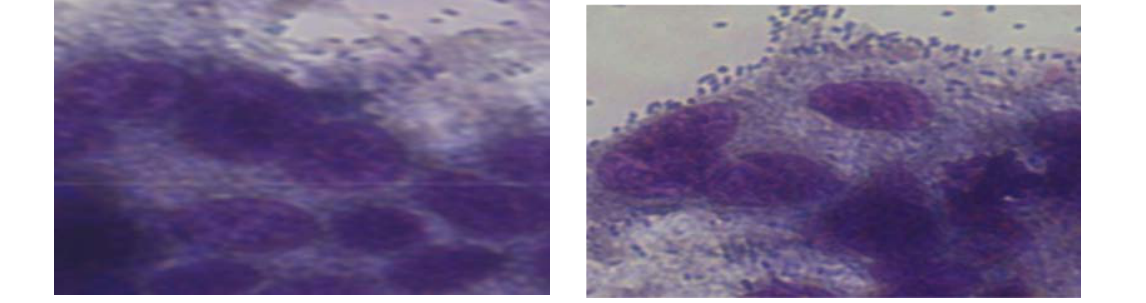
Fig. 7. (AvantBact) Pediococcus acidilactici adhesion study Adhesion of probiotic sample isolates to Caco-2 cell line observed under inverted microscope (40x) after staining with giemsa